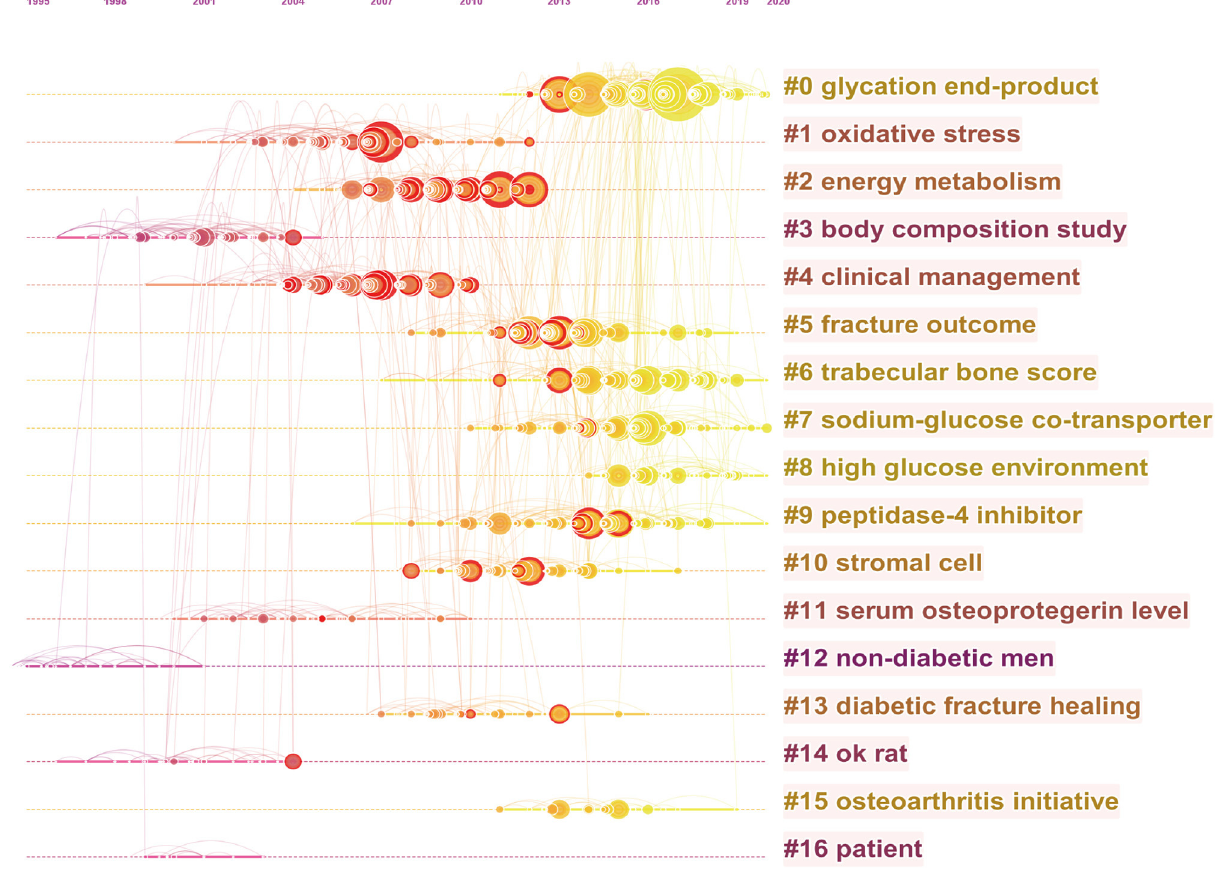
FIGURE 7 | The timeline view map of reference co-citation analysis generated by CiteSpace. Years from 2000 to 2021 are arranged horizontally at the top, and this view map clearly implies the differences in the appearance time point of 17 clusters. The bigger the circle size, the more research on the topic. The label of each cluster (LLR algorithm) is shown at the end of the